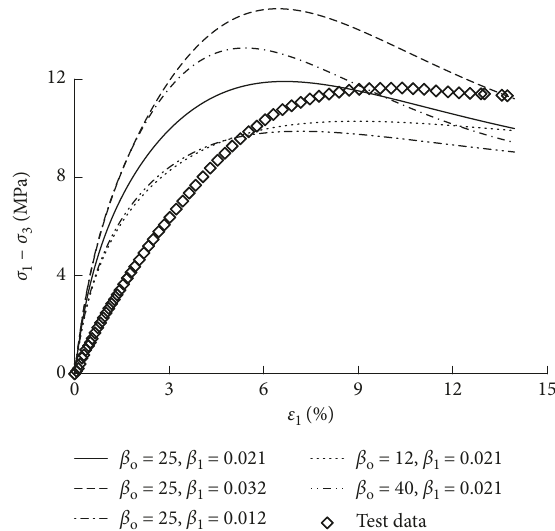
Figure 1: Simulation results of original generalized plasticity model.